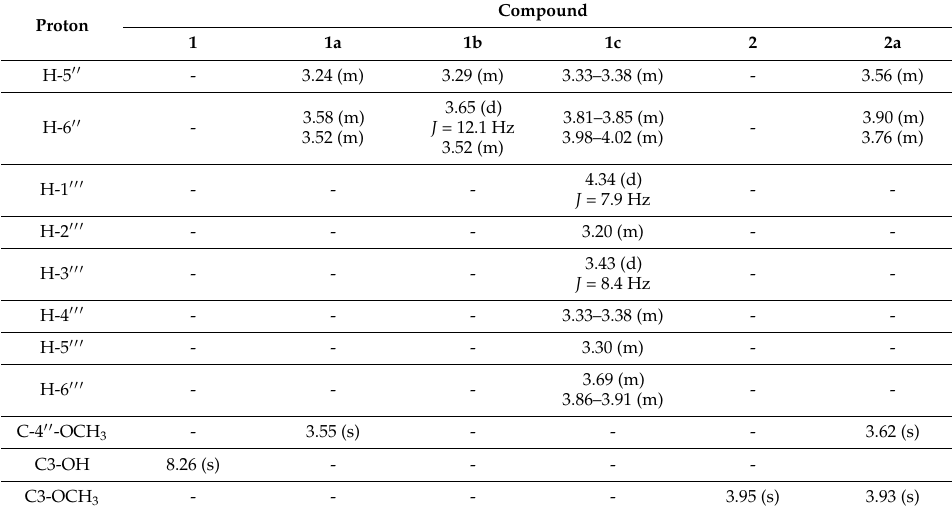
Table 2. 13 C-NMR shifts ( δ ) of 3-hydroxyflavone ( 1 ) and 3-methoxyflavone ( 2 ) and products of